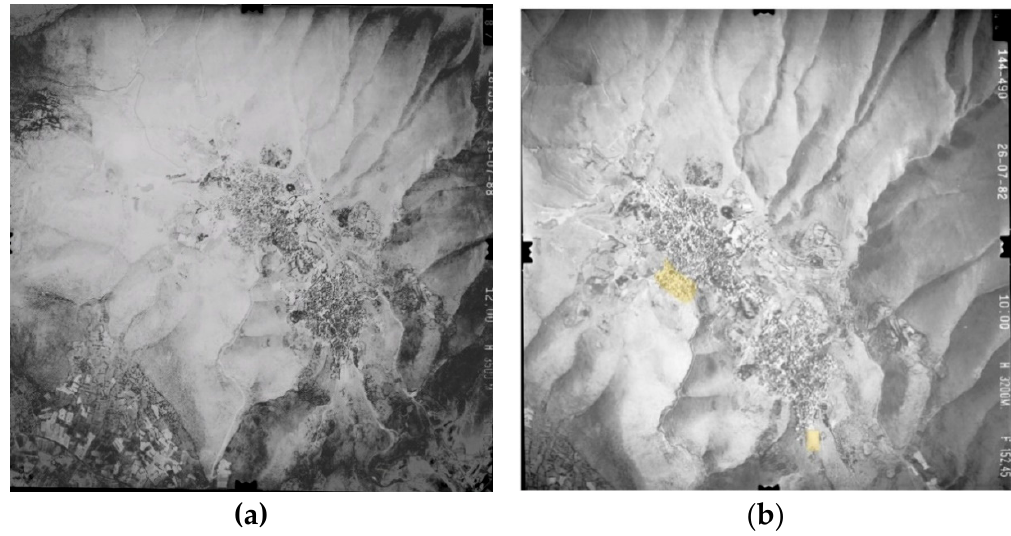
Figure 10. ( a ) Aerial photo of 1969. ( b ) Aerial photo of 1982.